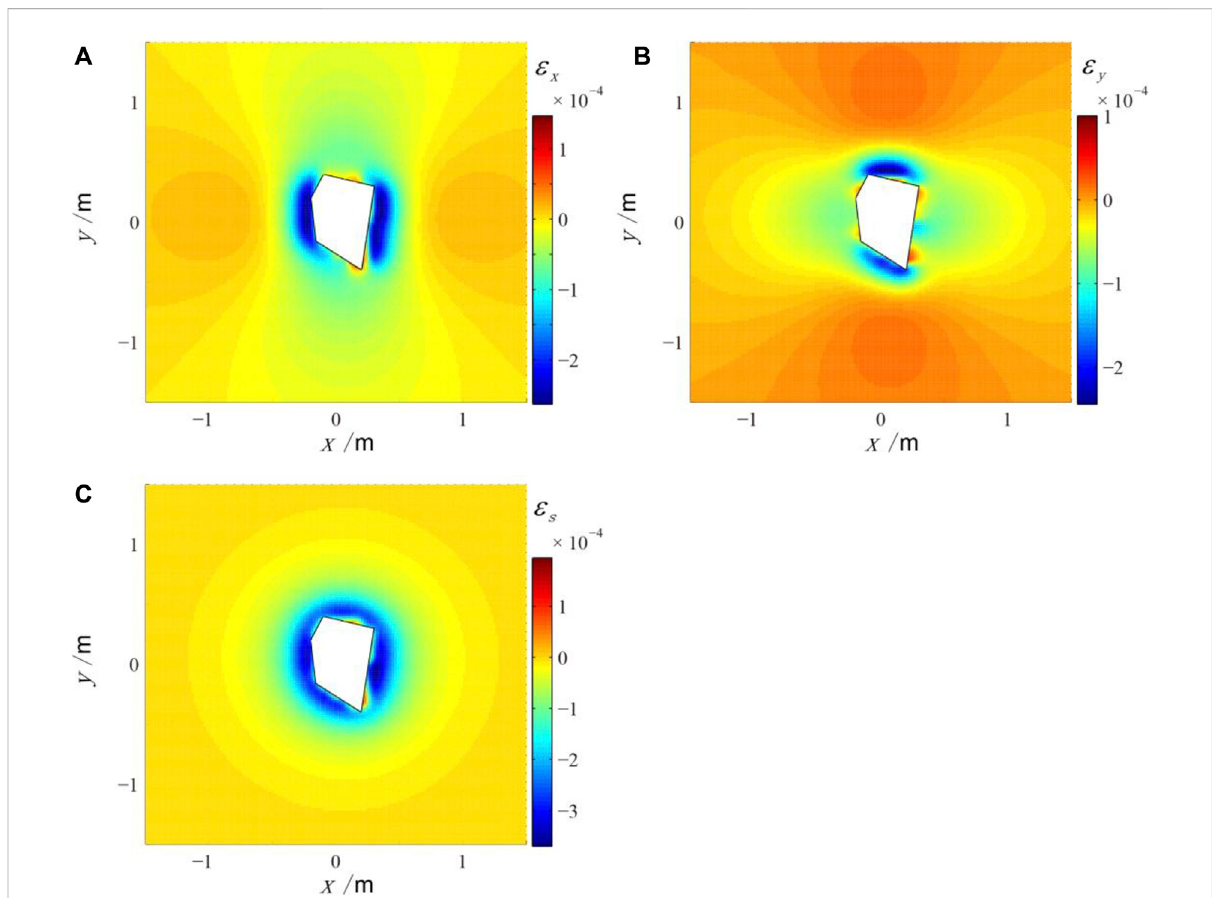
FIGURE 5 Thestrain fi elddisplacementaroundthe2Dirregularloadmodelinthedepthof0.2 m (A) Thelinearstrain ε x ; (B) Thelinearstrain ε y ; (C) Thearea strain ε s ; the white polygon represents the shape of irregular